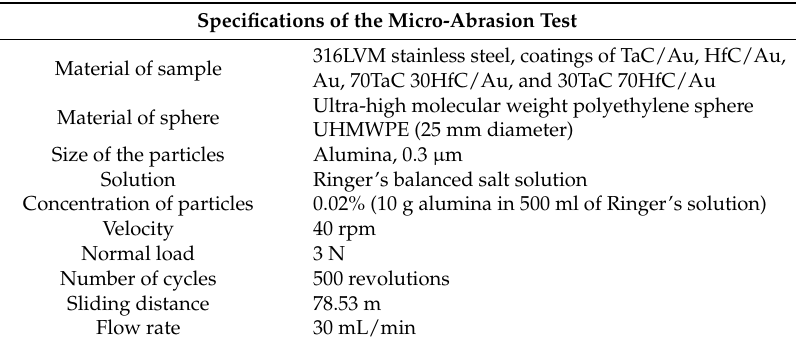
Figure 1. Schematic of the micro-abrasion test apparatus which allow applying a normal load between the coated samples and the ball also shows how the alumina particles are added to the system. With the aim to simulate biological conditions of a joint replacement by means of an ultra-high molecular weight polyethylene sphere and Ringer’s solution with alumina particles in suspension, the test parameters are shown in Table 1. Table 1. Test parameters.